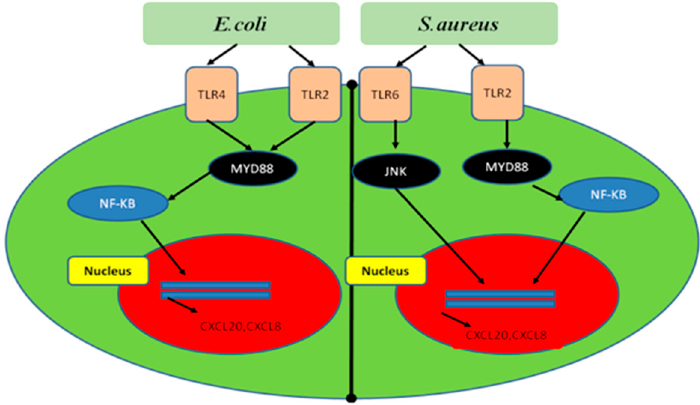
Figure 2. The interactive mechanism of E. coli and S. aureus with TLR2, TLR4 and TLR6, and the regulation of NF- κ B signaling to activate the inflammatory genes.